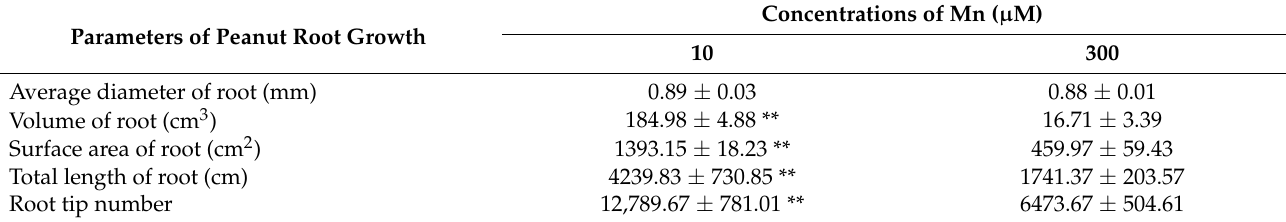
Table 2. Effects of different manganese concentrations on peanut root